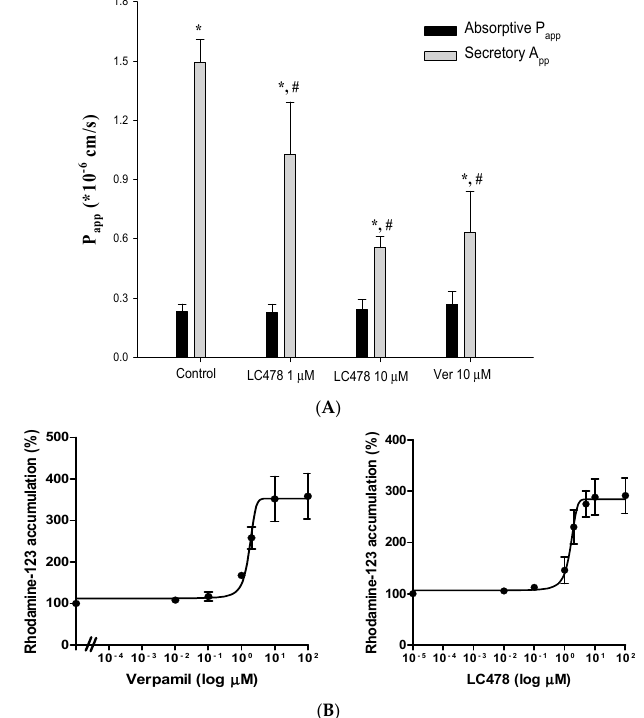
Figure 2. Effect of LC478 on P-gp mediated efflux of rhodamine-123. ( A ) Absorptive P app ( ■ ) and secretory P app ( ■ ) of rhodamine-123 with LC478 (1 and 10 μ M) or verapamil (10 μ M) across Caco-2 cells. Vertical bars represent standard deviation (SD) and the number of each group is three. * Significantly different ( p < 0.05) from absorptive (M to S) group. # Significantly different ( p < 0.05) from the control group. ( B ) The EC 50 curves of verapamil (left) and LC478 (right) on rhodamine-123 accumulation in Caco-2 cells. Vertical bar represents standard error of the mean (SEM) and number of each group is three.